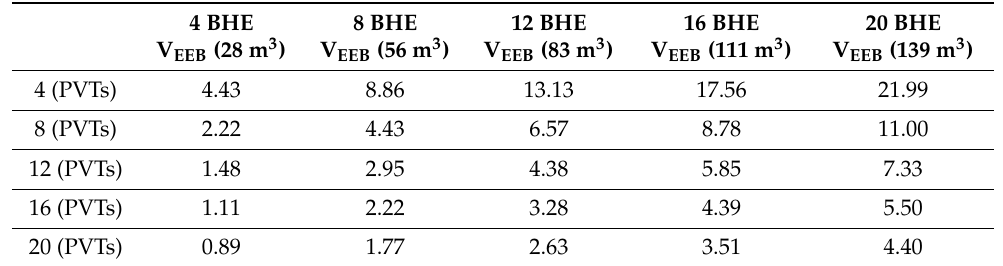
Table 3. Storage capacity [m 3 /m 2 ) as product of the heat storage volume allocated to the EEB and the utilized PVT